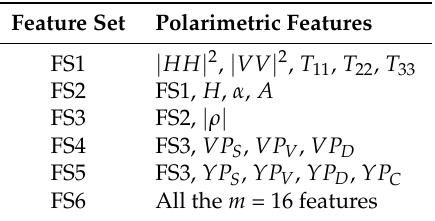
Table 6. Detailed content of feature sets. Feature Set